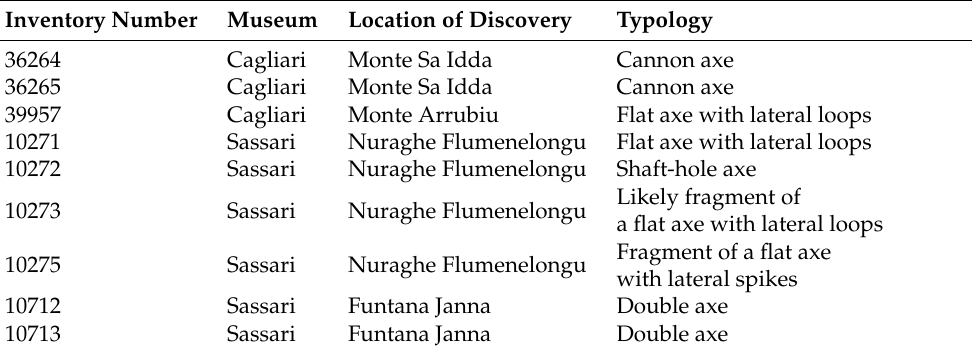
Table 1. List of analyzed samples with their inventory numbers, places of conservation, places of discovery, and artifact